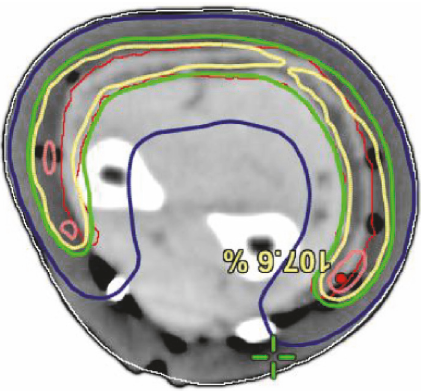
Figure 6: VMAT allows treating of a convex forearm, leaving a strip for lymph flow.